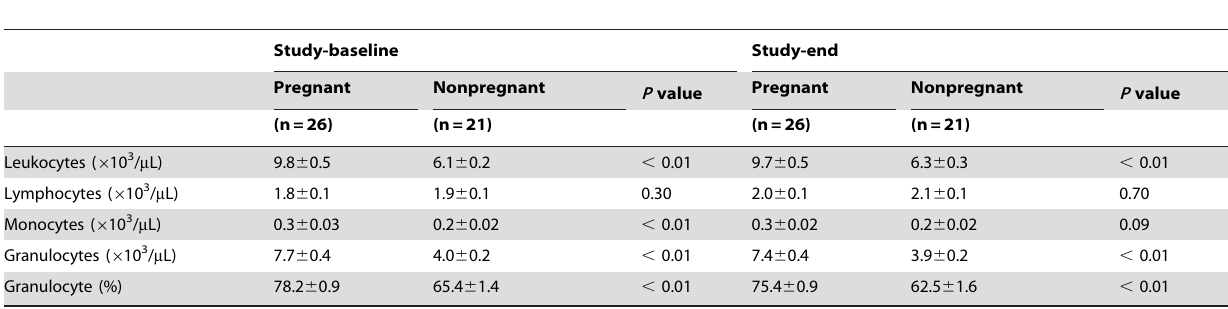
Table 2. Peripheral blood leukocyte counts in third trimester pregnant women and nonpregnant women at the beginning and end of the controlled feeding study.